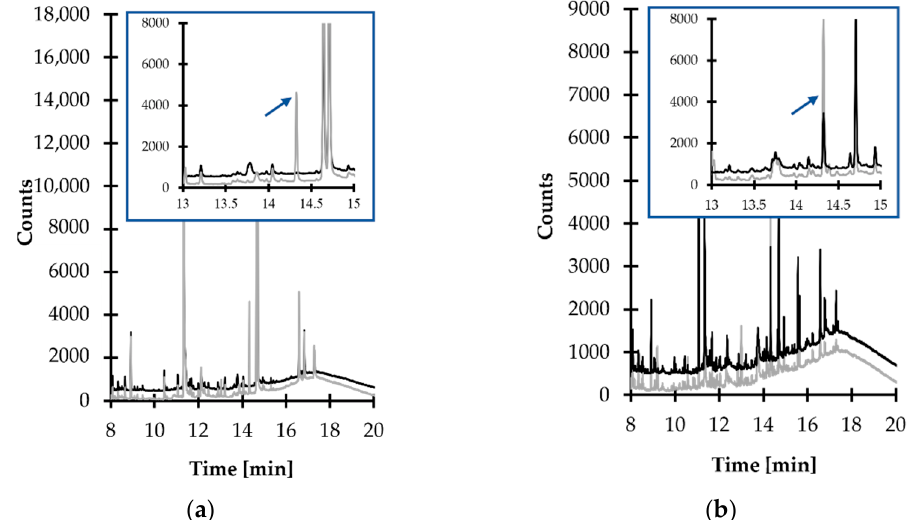
Figure 5. Representative chromatograms of standard solutions and human urine prepared according to the procedure described in Section 3.5. Chromatographic conditions were as described in Section 3.6. ( a ) Blank standard solution (black line) and standard solution of 1,3-thiazinane-4-carboxylic acid (TCA) (50 µmol L − 1 in urine) (grey line); ( b ) normal human urine sample (black line) and the same sample spiked with the analyte (50 µmol L − 1 in urine) (grey line). Under these conditions, the peak of the isobutyl derivative of TCA (TCA-IBCF) appears at 14.3 min.